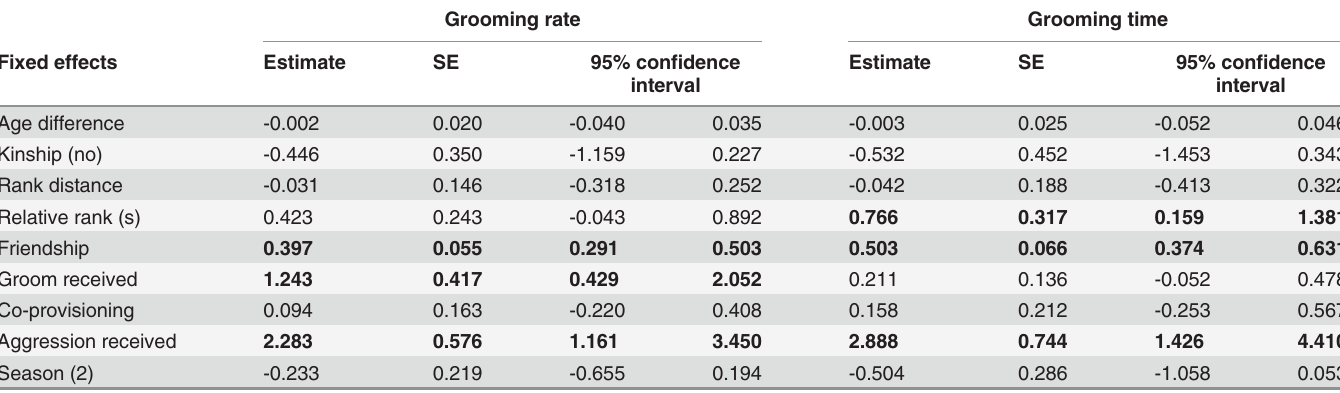
Table 3. Results of LMMs testing grooming rate and grooming time and their relationship to kinship, rank distance, relative rank, friendship, grooming received, co-provisioning, aggression received and season among females with low rank distance. Grooming rate Grooming